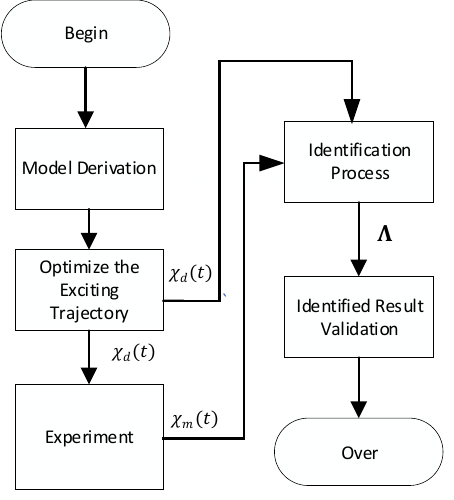
Figure 4. Sketch of the identification